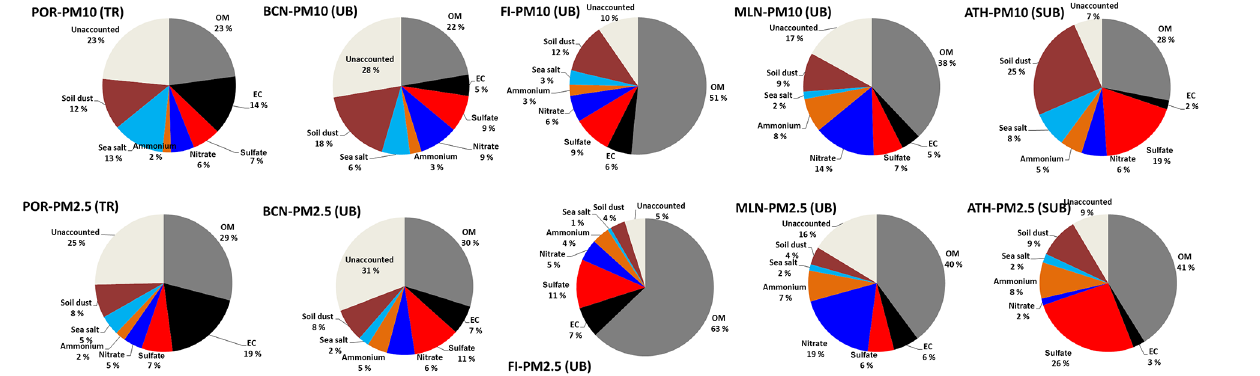
Figure 1. Mass closure of PM 10 and PM 2 . 5 chemical speciation data for the five AIRUSE